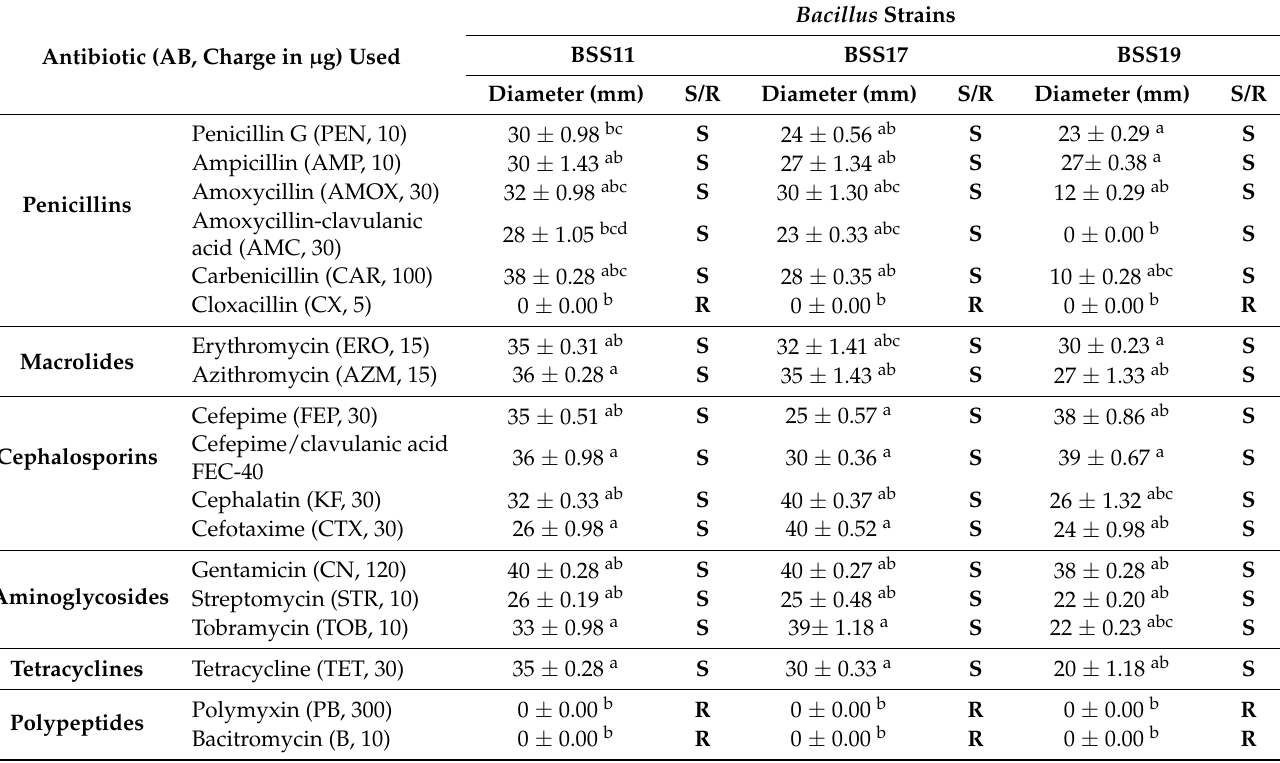
Table 3. Antibiotic resistance profile of the Bacillus strains.